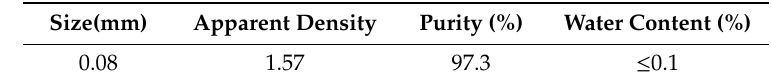
Table 2. Properties of silica sand.